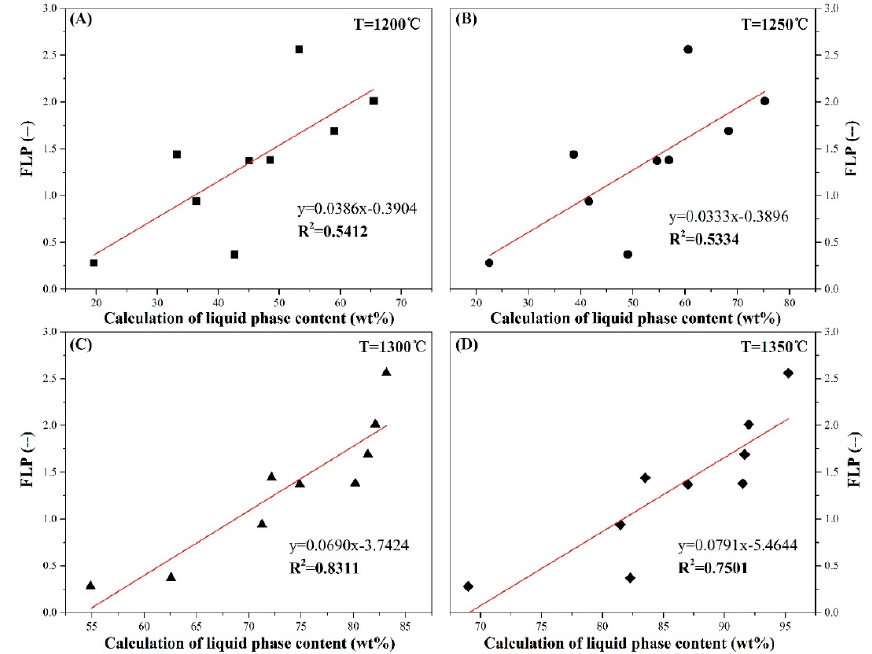
Figure 8. Relationship between FLP and liquid phase content under different sintering temperatures.